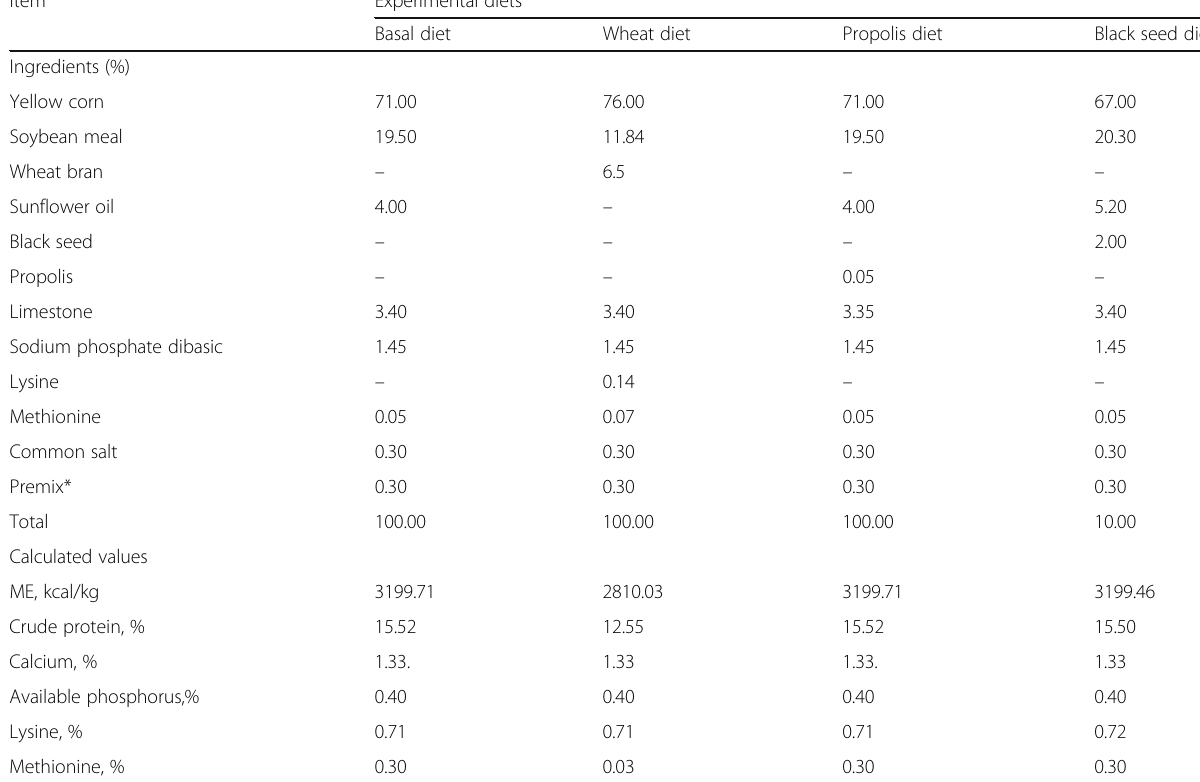
Table 1 Composition and chemical analysis of the experimental diets